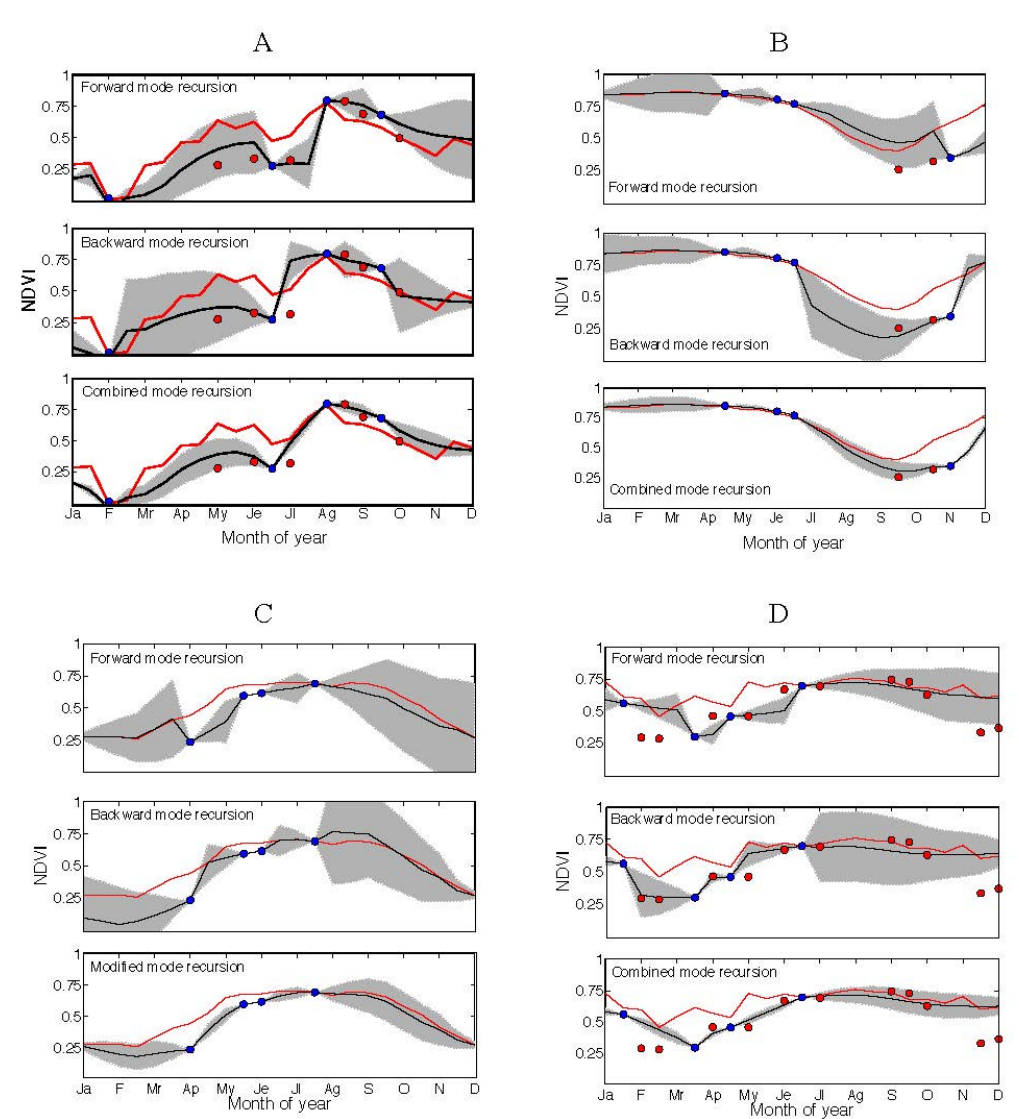
Figure 9. NDVI pixel values for combined mode Kalman filter implementation time series for ( A ) Kansas, ( B ) Mozambique, ( C ) Manitoba and ( D ) Arizona for forward, backward and combined recursive modes. The black line shows the NDVI time series retrieved from the Kalman filter implementation. The grey area indicates model uncertainties (±standard deviation from model estimate). The red line shows the average seasonal NDVI pattern extracted from the MODIS NDVI 16-day composites (MOD13Q1). The blue dots indicate the time steps for which Landsat images where used as model observations. The blue dots indicate the time steps for which Landsat images were used as model